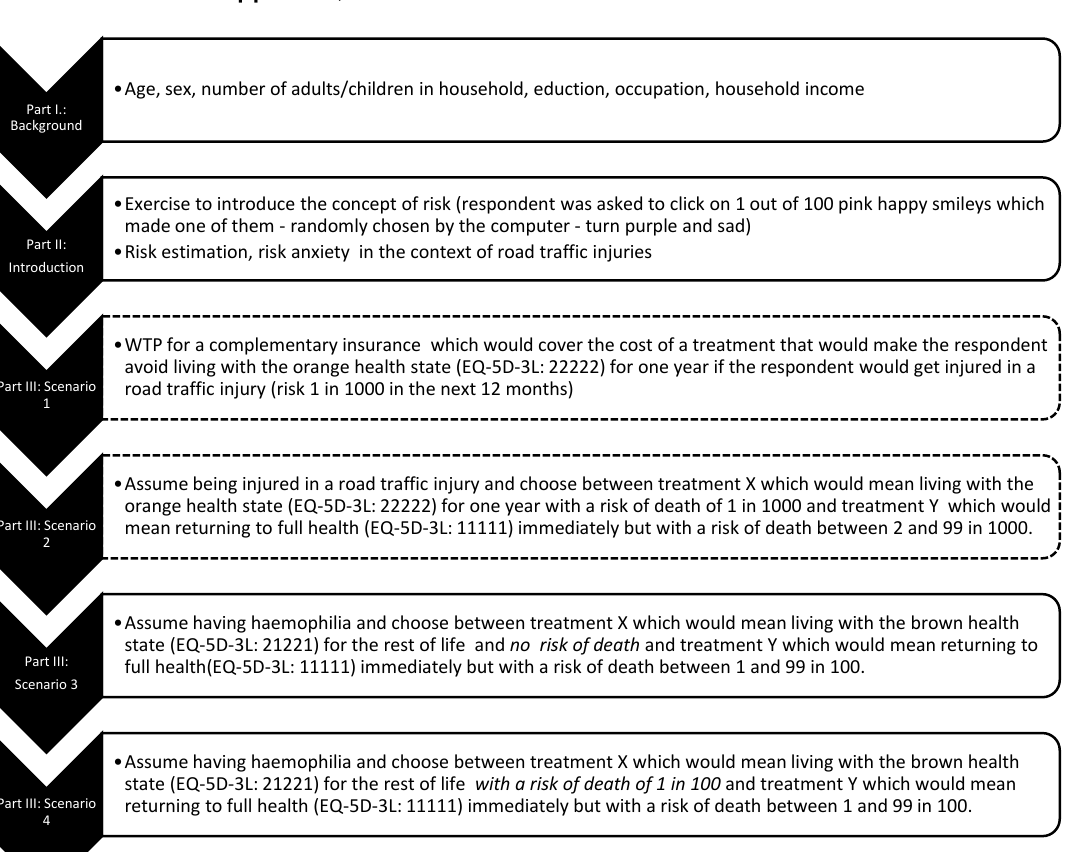
Flow chart of the questionnaire (dashed boxes are scenarios used in the chained